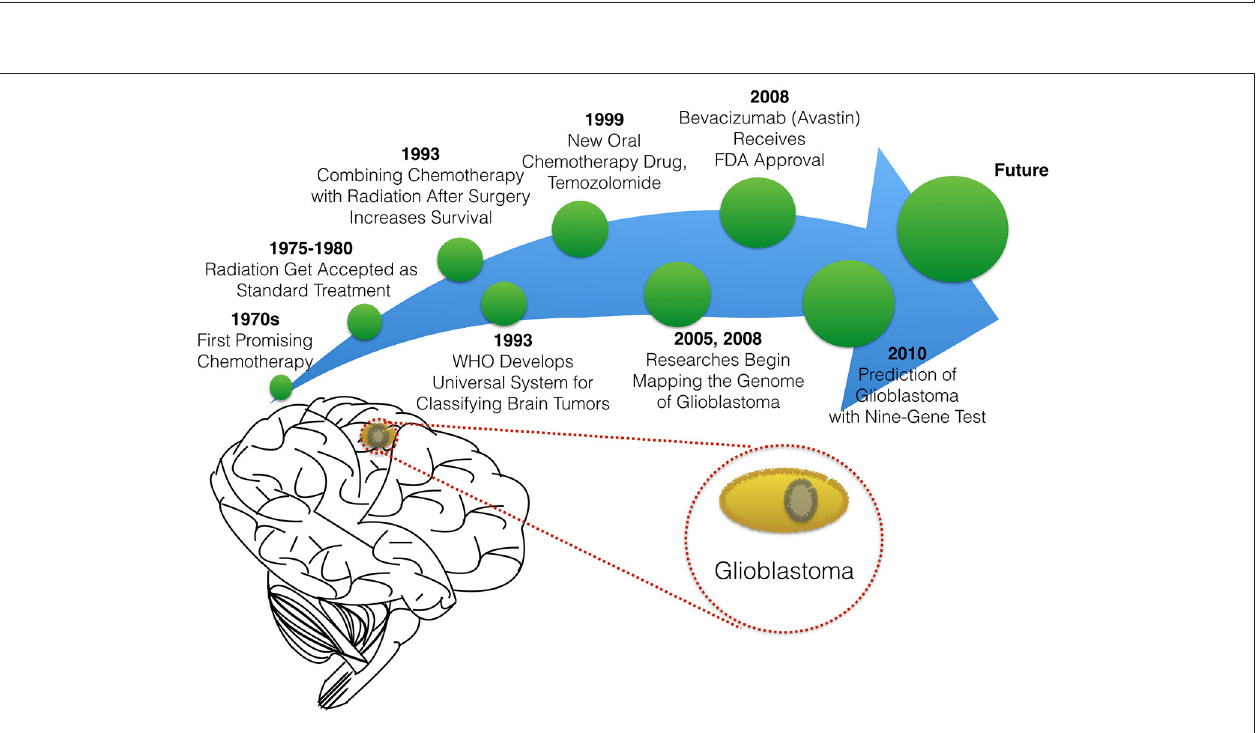
FIGURE 2 | The timeline of glioblastoma